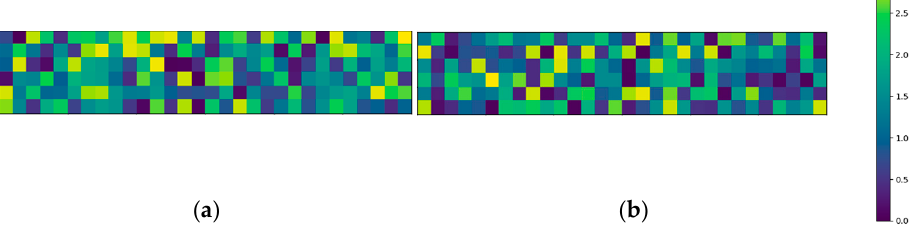
Figure 3. Flaw orientation distribution for ( a ) top and ( b ) bottom surfaces (with a flaw density of 1 flaw/cm 2 for visualization).